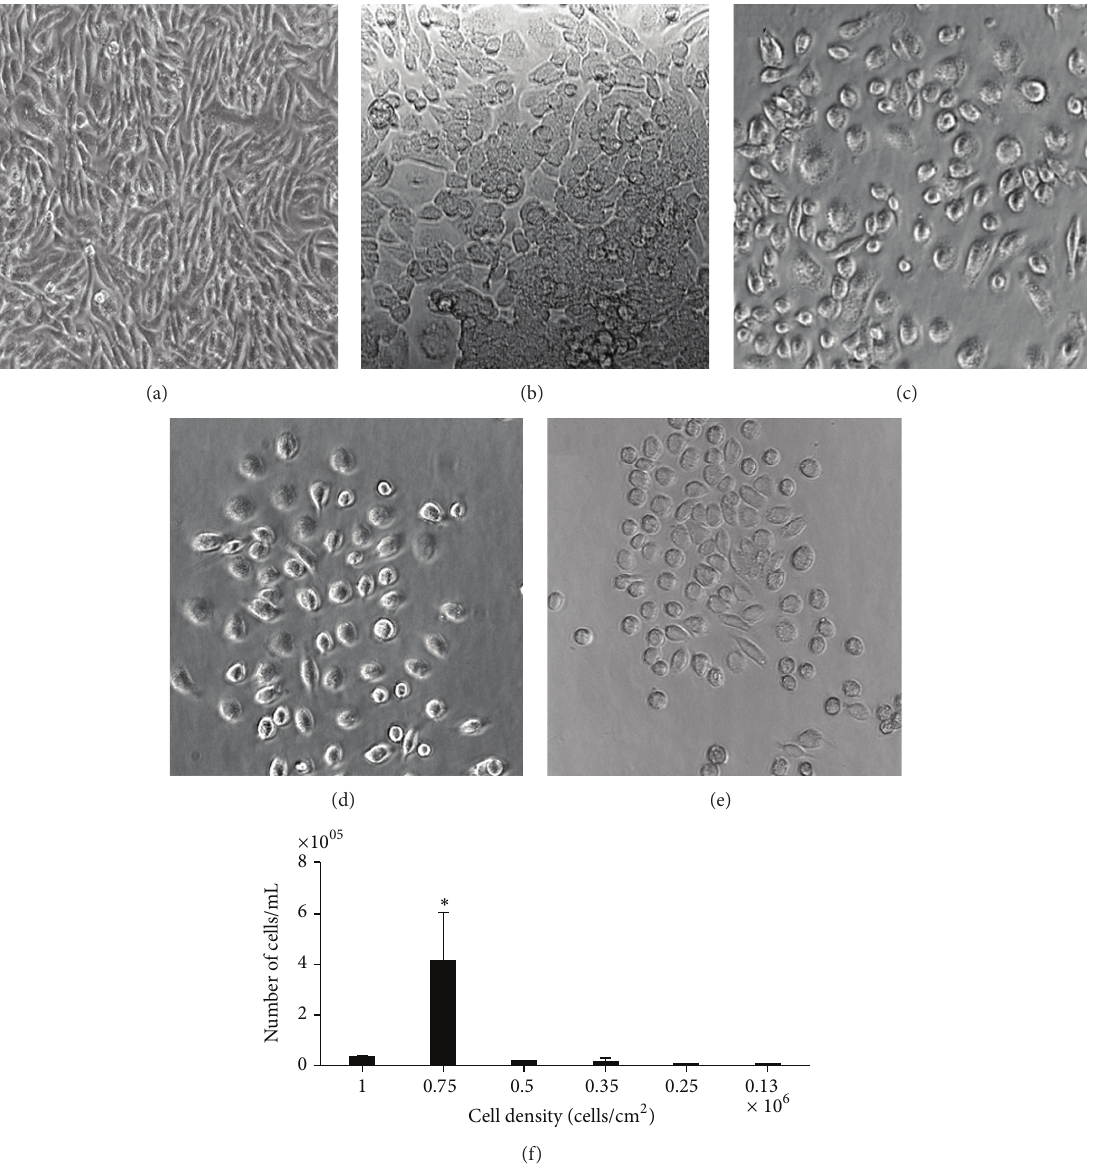
Figure 3: Influence of initial seeding cell densities on the microglia culture. Mixed retinal cells seeded at 0.75–1 × 10 6 cells/cm 2 produced the highest cell numbers. (a) 1 × 10 6 cells/mL. (b) 0.75 × 10 6 cells/mL. (c) 0.5 × 10 6 cells/mL. (d) 0.25 × 10 6 cells/mL. (e) 0.13 × 10 6 cells/mL. After 15–20 days of culture, retinal microglial cells were observed using a phase-contrast Olympus microscope and Prog Res C14 imaging software. Magnification × 20. Cells were counted using haemocytometer and trypan blue was used to distinguish viable and dead cells. Error bars are SEM. ∗ 𝑃 < 0.05 , compared to others